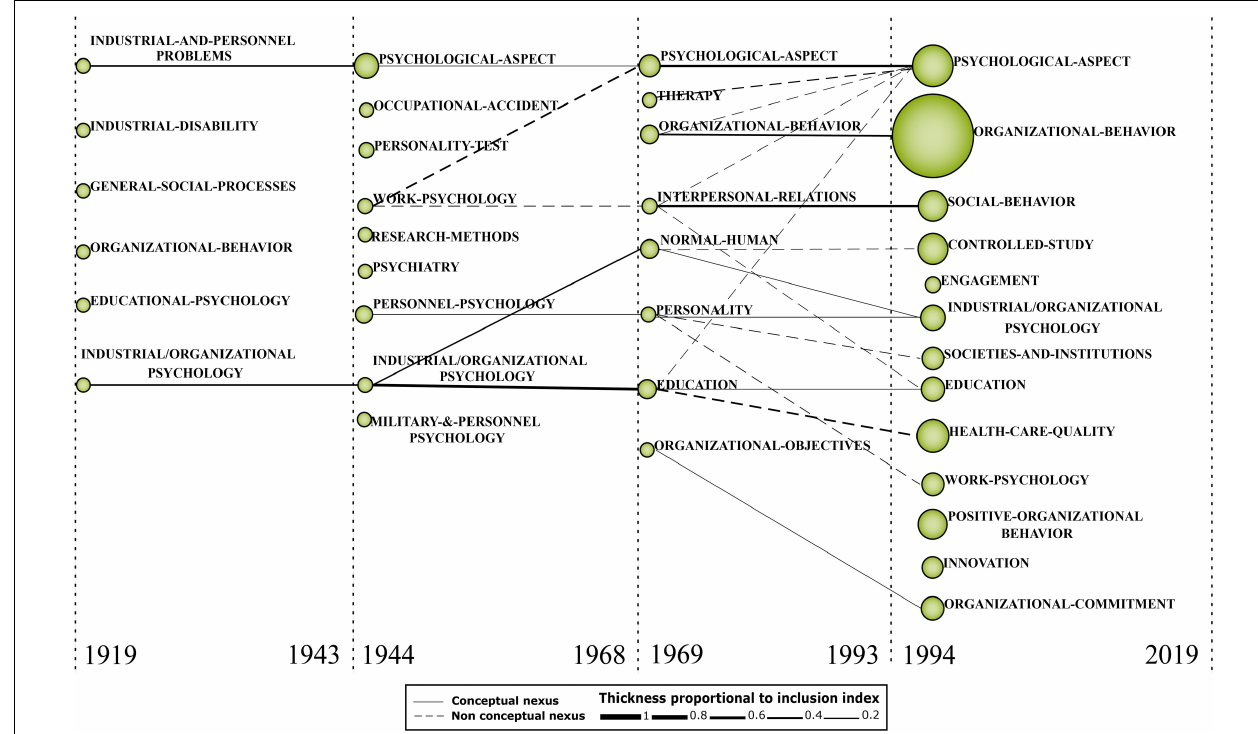
FIGURE 4 | Evolution of thematic